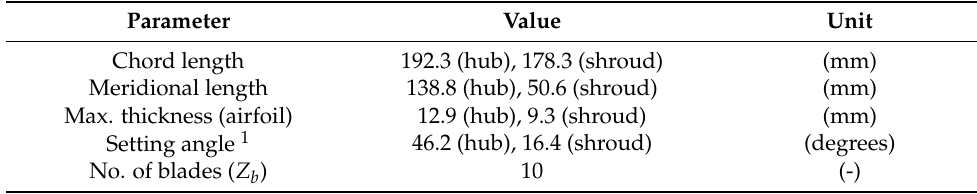
Table 2. Design parameters of the blade.